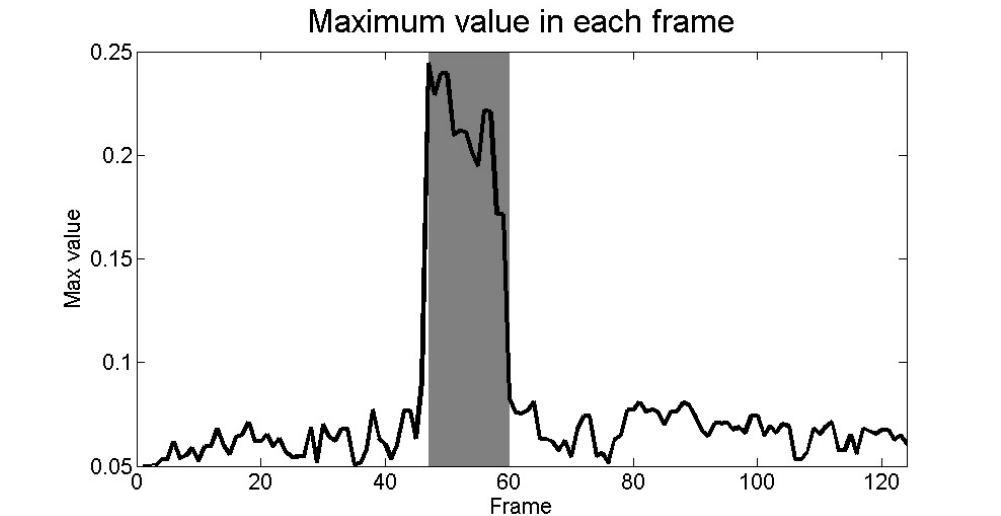
Figure 4. Plot of maximum values in the frames after pre-processing. The frames where an animal (the rabbit in this case) is present is marked with dark-grey. It is therefore possible to detect the presence of the animal on the basis of the maximum values in the